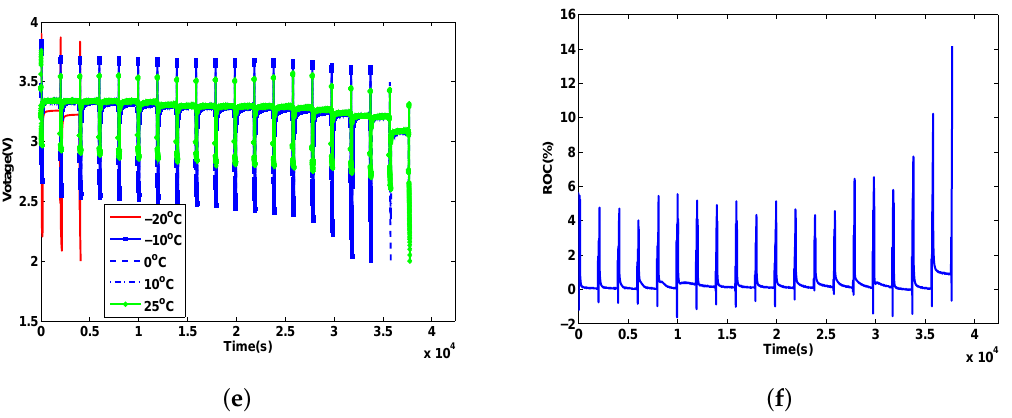
Figure 5. Experimental pulse discharge curves at various temperatures with a discharge current of: ( a ) Figure 4a; ( c ) Figure 4c and ( e ) Figure 4e and the ROC curves ( b ); ( d ) and ( f ).